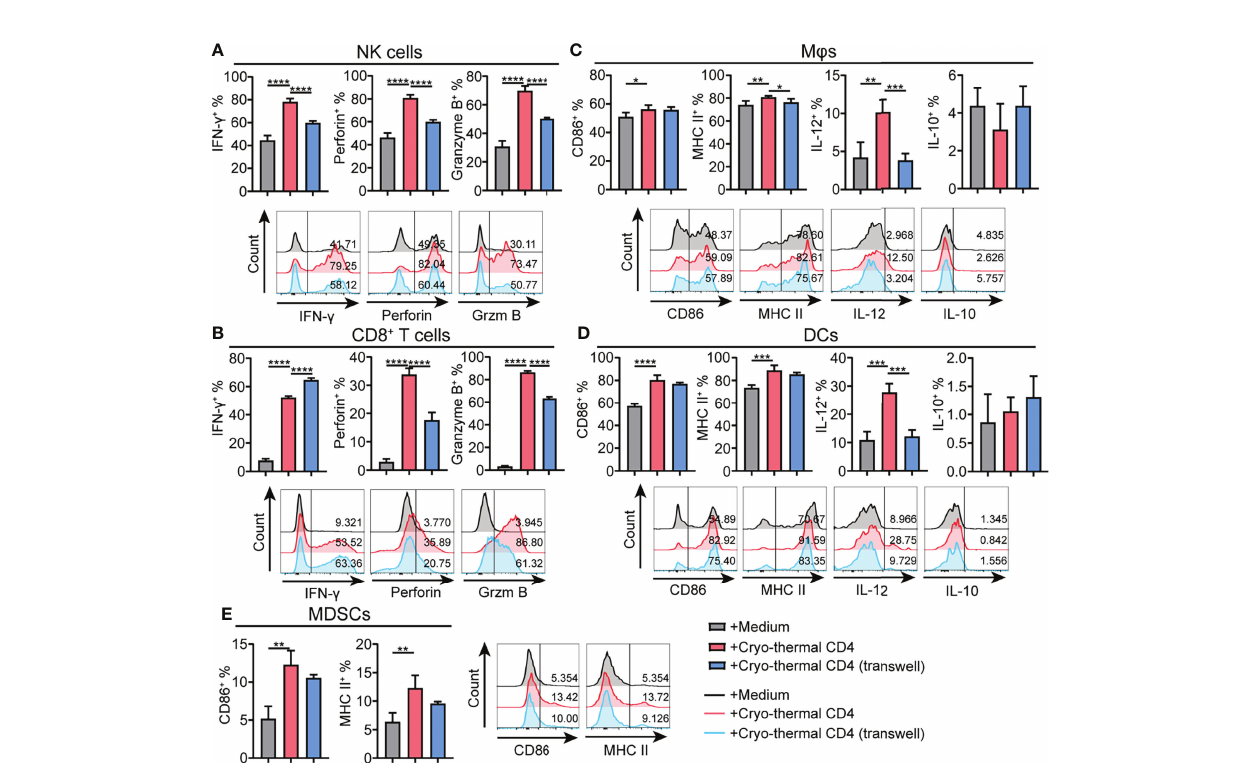
FIGURE 4 | Phenotype of immune cells regulated by cryo-thermal CD4 + T cells is dependent on cell-cell contact in vitro . (A-E) MACS-isolated cryo-thermal CD4 + T cells were stimulated with anti-CD3 monoantibody, washed and then cocultured with cryo-thermal CD4 - splenocytes together or separated with a transwell plate for 24 hours. The phenotype of (A) NK cells, (B) CD8 + T cells, (C) M j , (D) DCs and (E) MDSCs were analyzed by fl ow cytometry. All data were shown as mean±SD. n =4 for each group. *P < 0.05, **P < 0.01, ***P < 0.001, ****P < 0.0001. Data for graphs were calculated by using two-sided Student ’ s